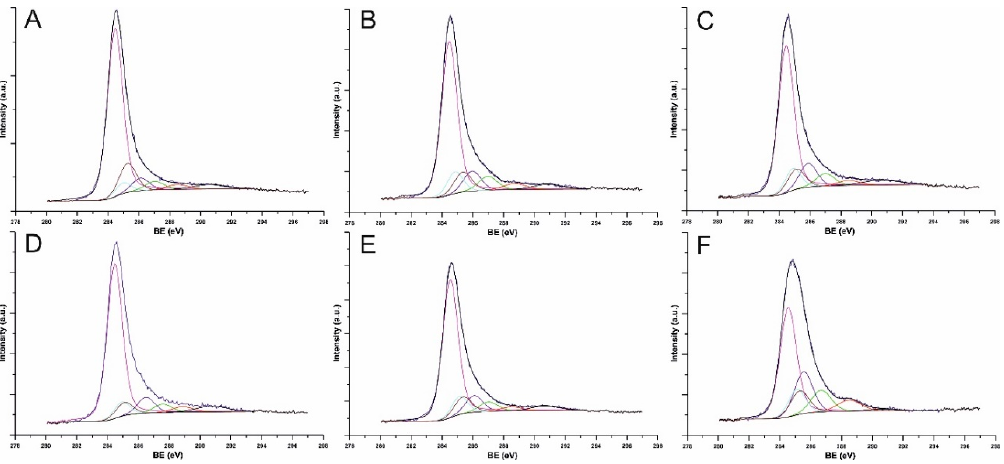
Figure 8. High resolution X-ray photoelectron spectroscopy (XPS) of Nanocyl NC7000 TM MWCNTs obtained in the C 1s bonding energy region for: halogenated CNTs with ICl 3 ( A ), halogenated CNTs using ICl ( B ), O -arylated CNTs ( C ), N -arylated CNTs ( D ), C -arylated CNTs ( E ), modified with 1,3,5-trihydroxybenzene (THB) ( F ).